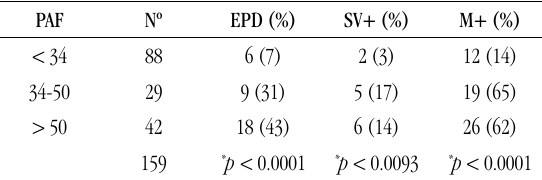
tABLE 3 – Incidence of pathological findings in the different stratification levels of the percentage of affected